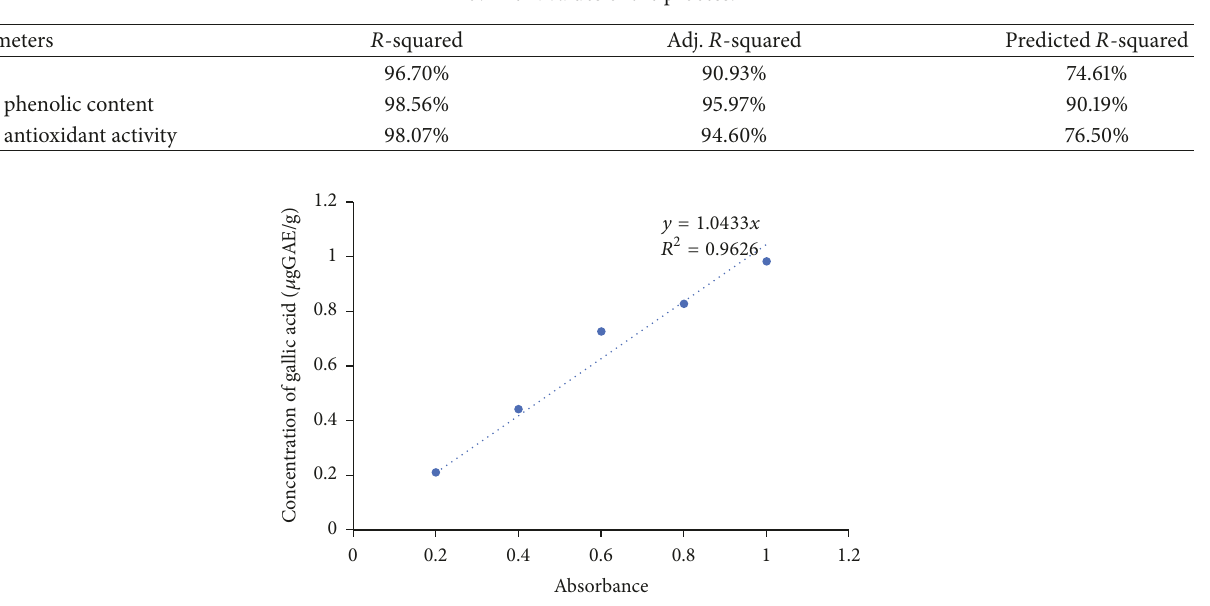
Table 5: The 𝑅 values of the process.